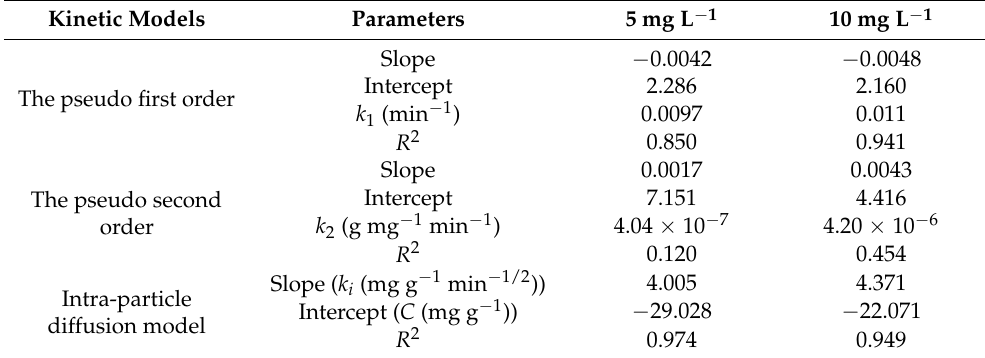
Table 3. Kinetic adsorption model parameters of Cu 2+ by sandwich adsorptive membrane.